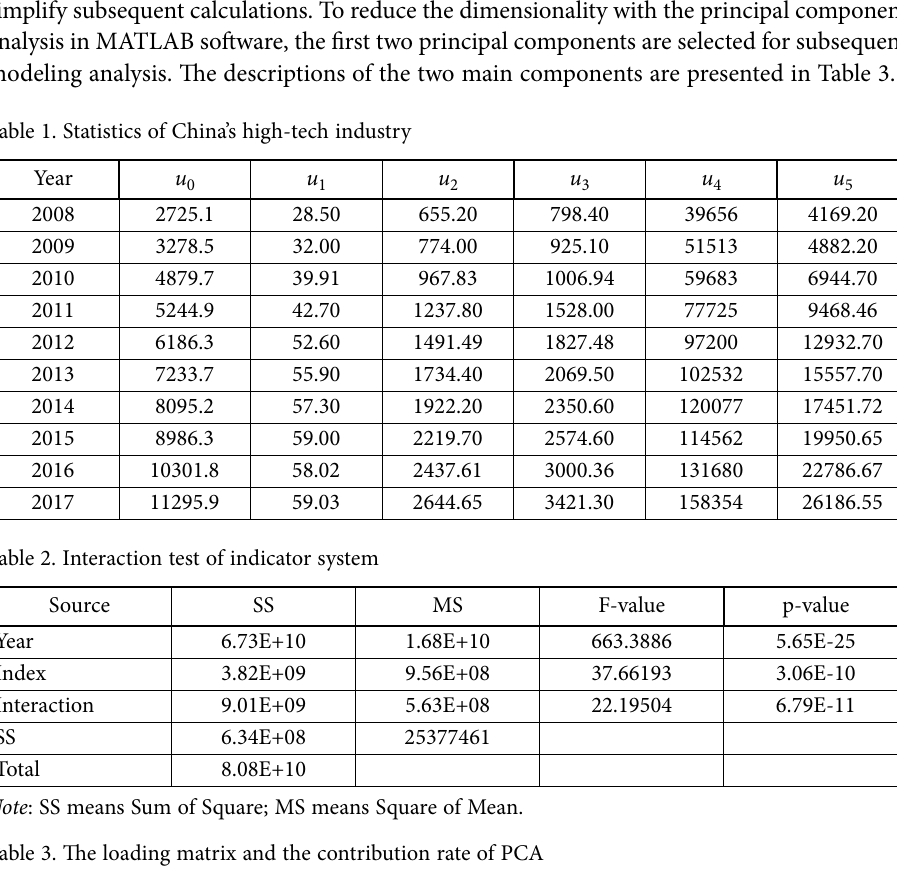
Table 3. The loading matrix and the contribution rate of PCA